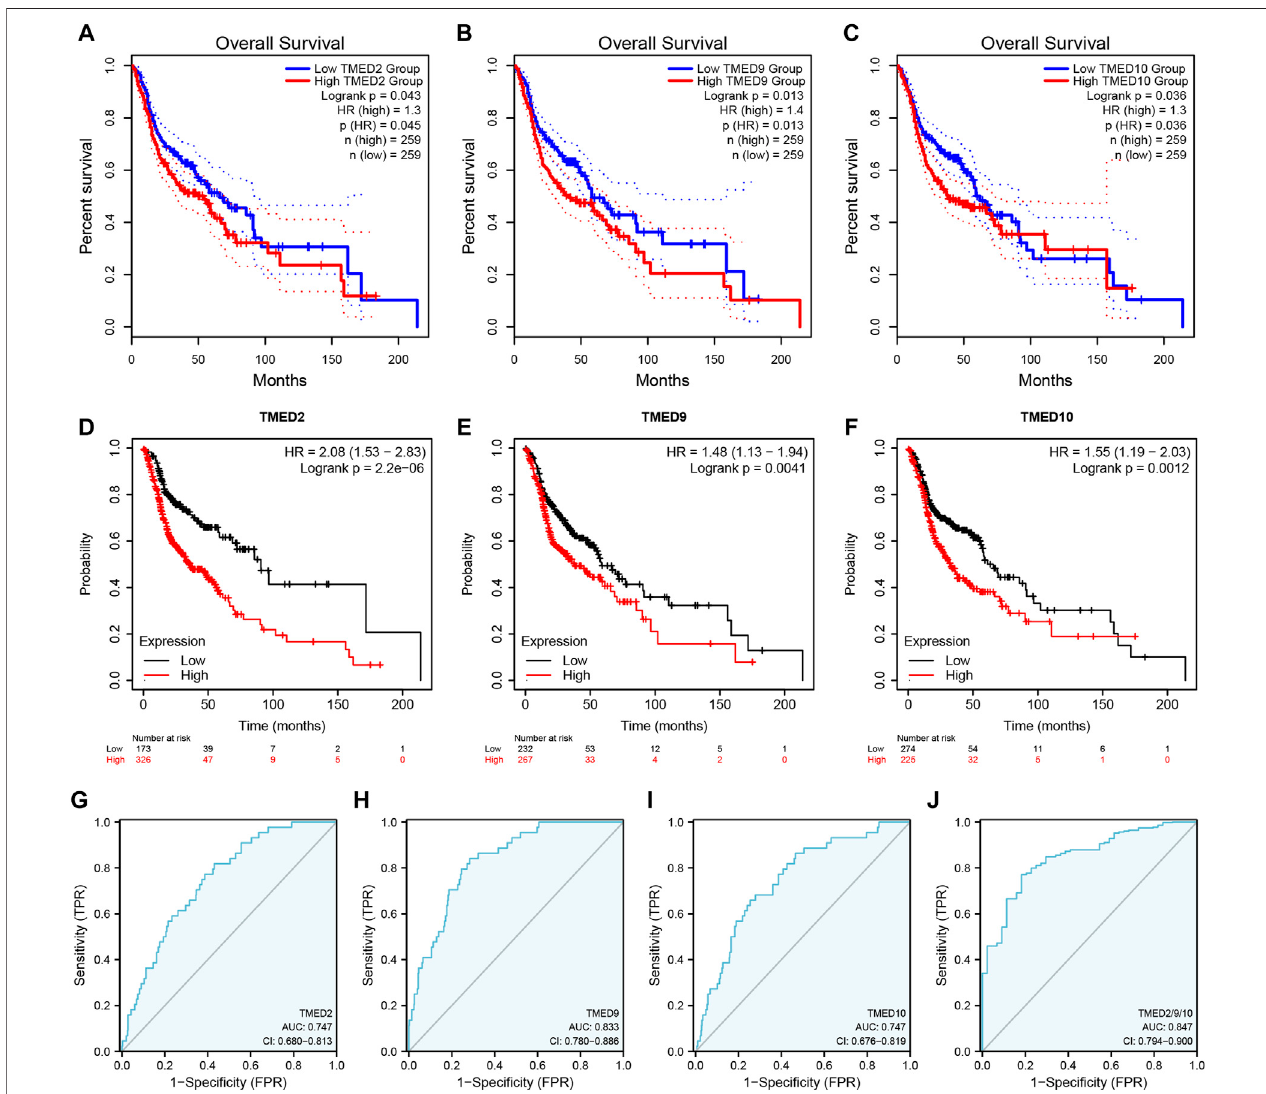
FIGURE 3 | The prognostic value of TMED2/9/10 in HNSC patients based on (A – C) the GEPIA 2 database and (D – F) Kaplan-Meier Plotter database. The diagnostic value of (G) TMED2, (H) TMED9, (I) TMED10 and (J) the combination of TMED2/9/10 in HNSC patients.